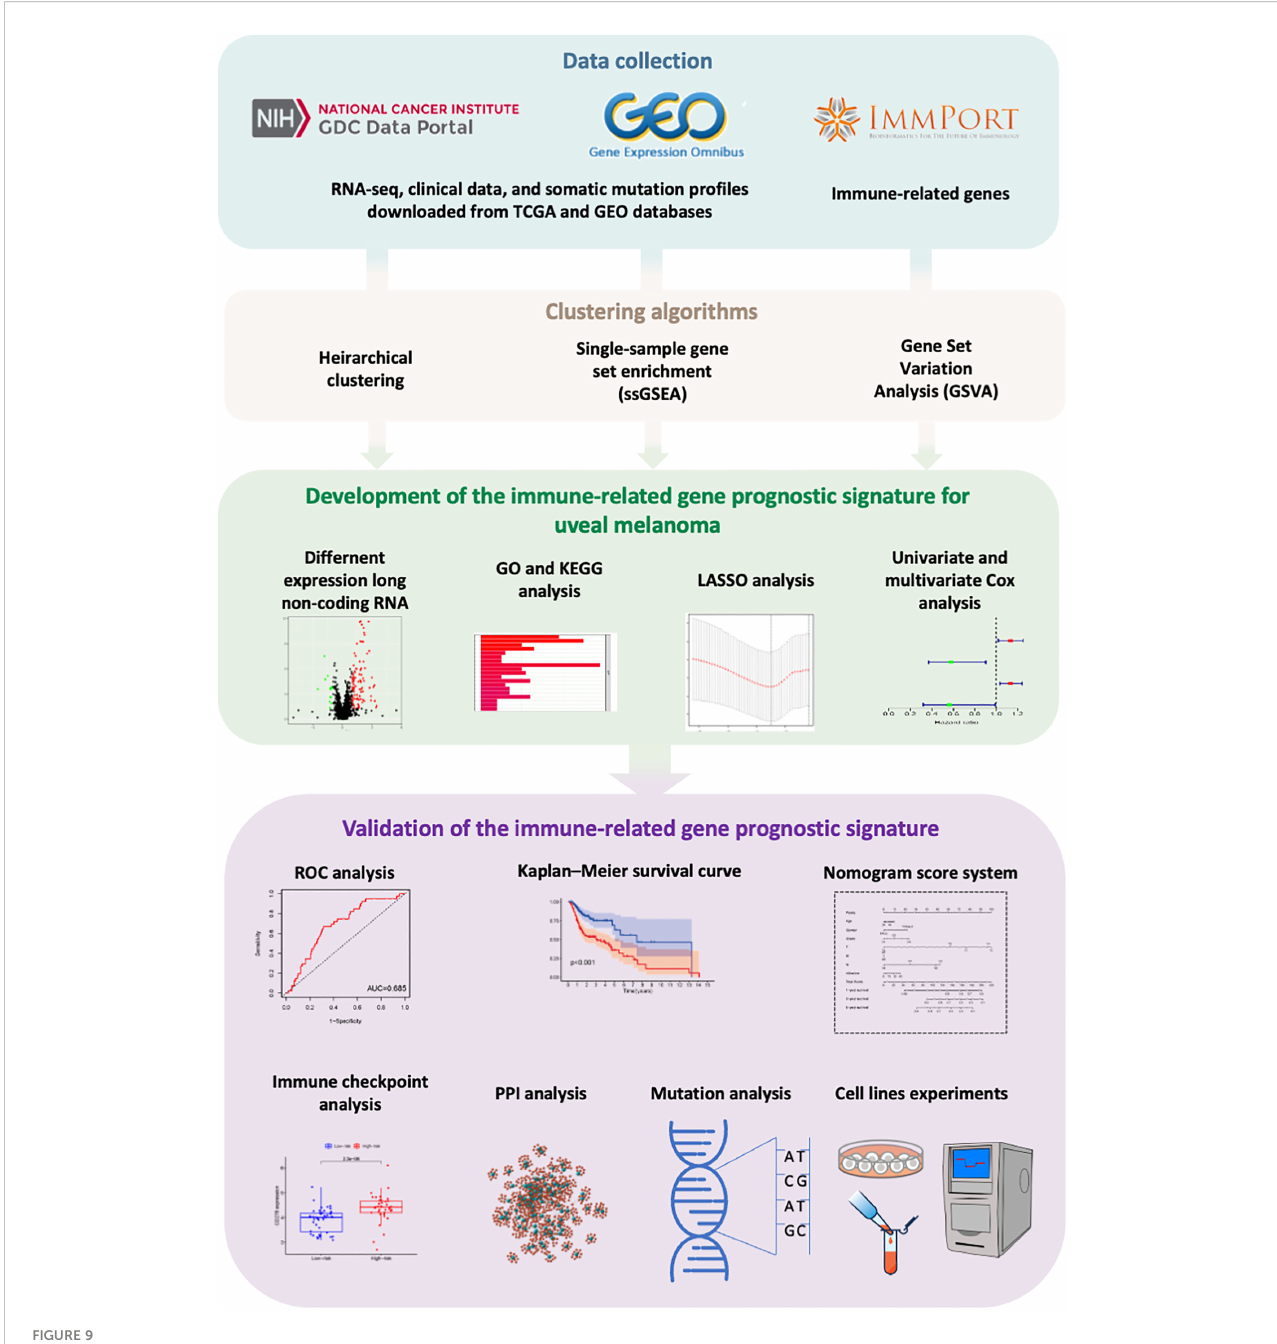
FIGURE 9 The work fl ow of this